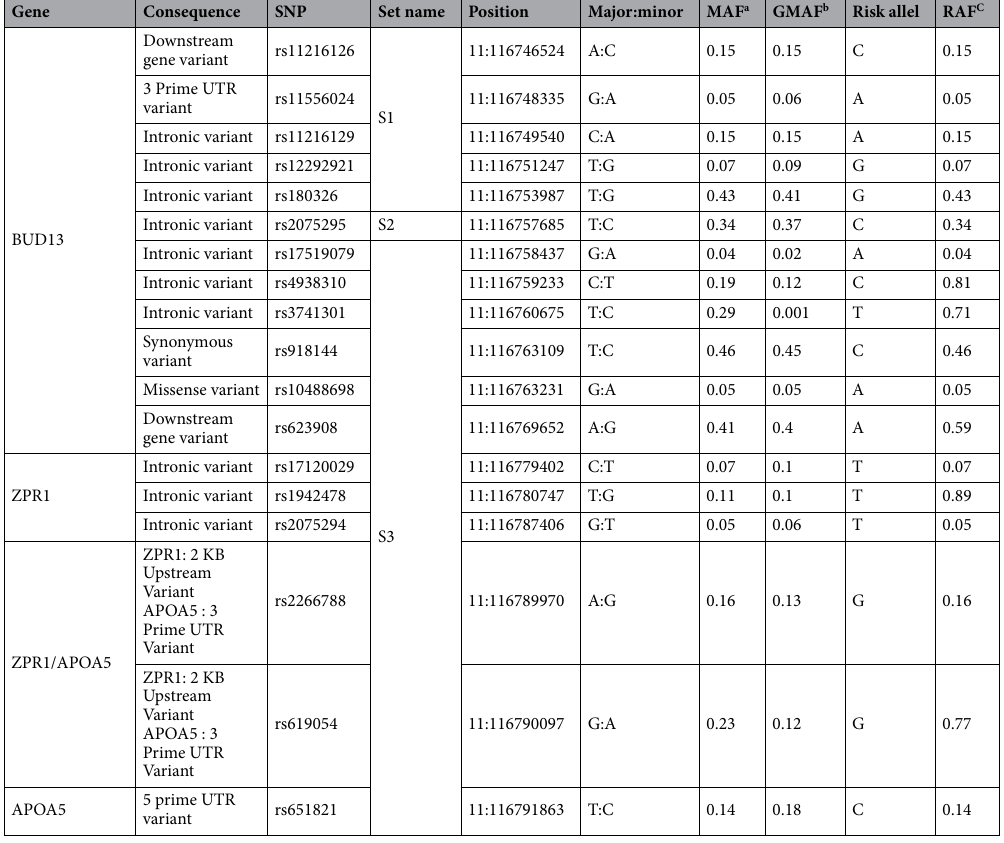
Table 2. Characteristics of the Markers in selected chromosomal region. a Minor allele frequency in Iranian population. b Global minor allele frequency. c Risk allele